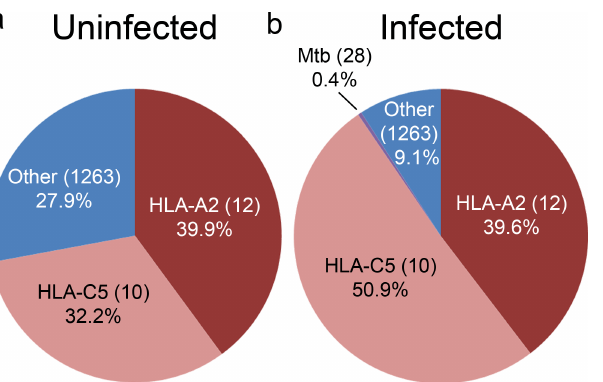
Fig 3. Mtb infection alters the HLA-E host ligand repertoire and results in a minor Mtb-specific ligand pool. Percentage of total ion intensity as determinedin the materials and methods section of indicatedHLA-E ligandgroupsfrom uninfected(A) or Mtb infected cells